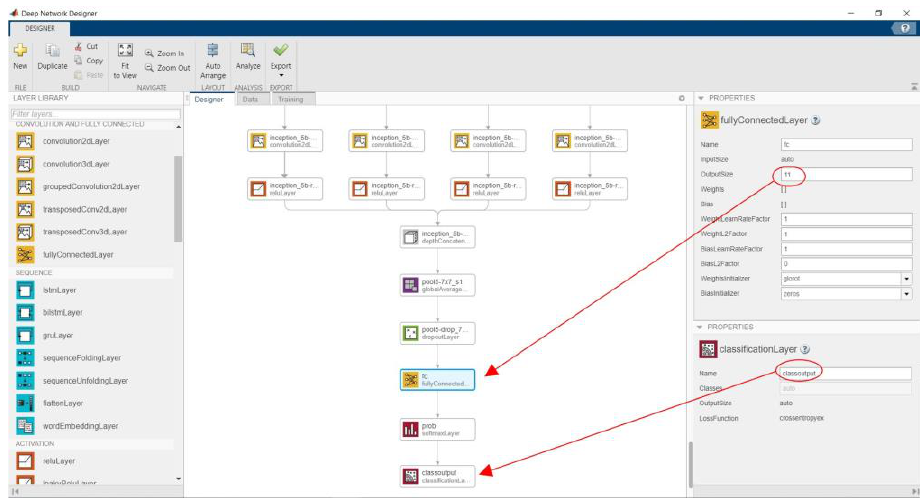
Figure 6. Modifying the GoogleNet architecture using Deep Network Designer.